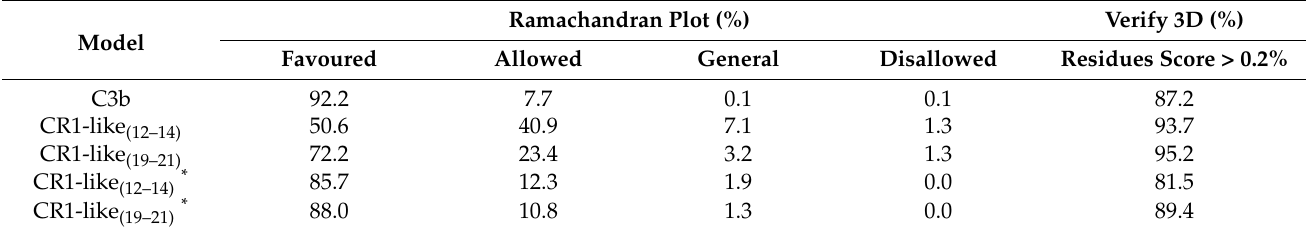
Table 1. Model optimization evaluation.